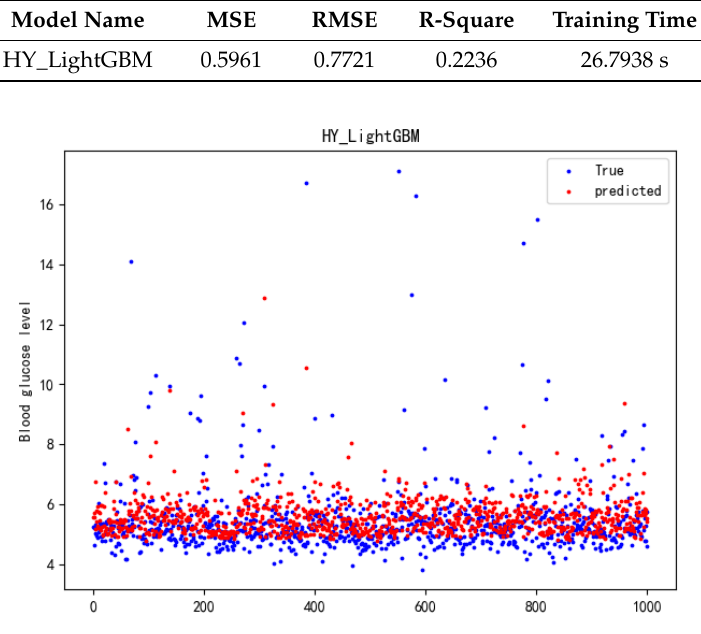
Figure 10. Scatter diagram of prediction results of HY_LightGBM model.